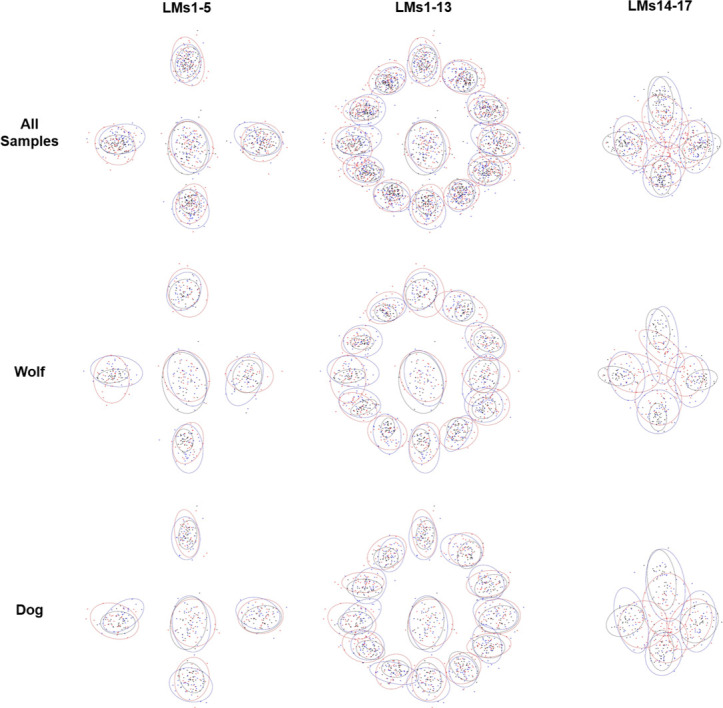
Fully superimposed landmarks in shape space and 95% Confidence ellipses calculated for spatial distributions (A1 = Red, A2 = Blue, A3 = Black).